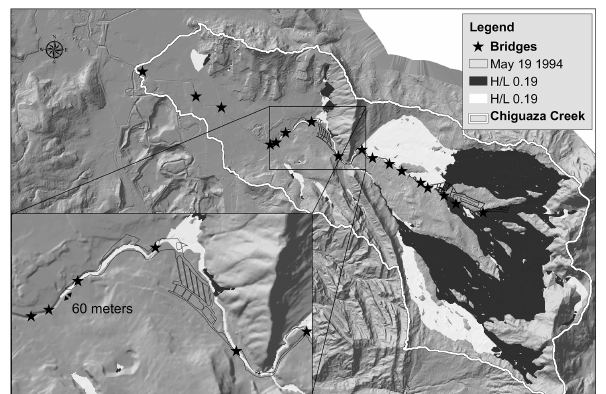
Figure 6. Affected area in the Chiguaza Creek on 19 May 1994 compared with propagation areas obtained from the MSF model.